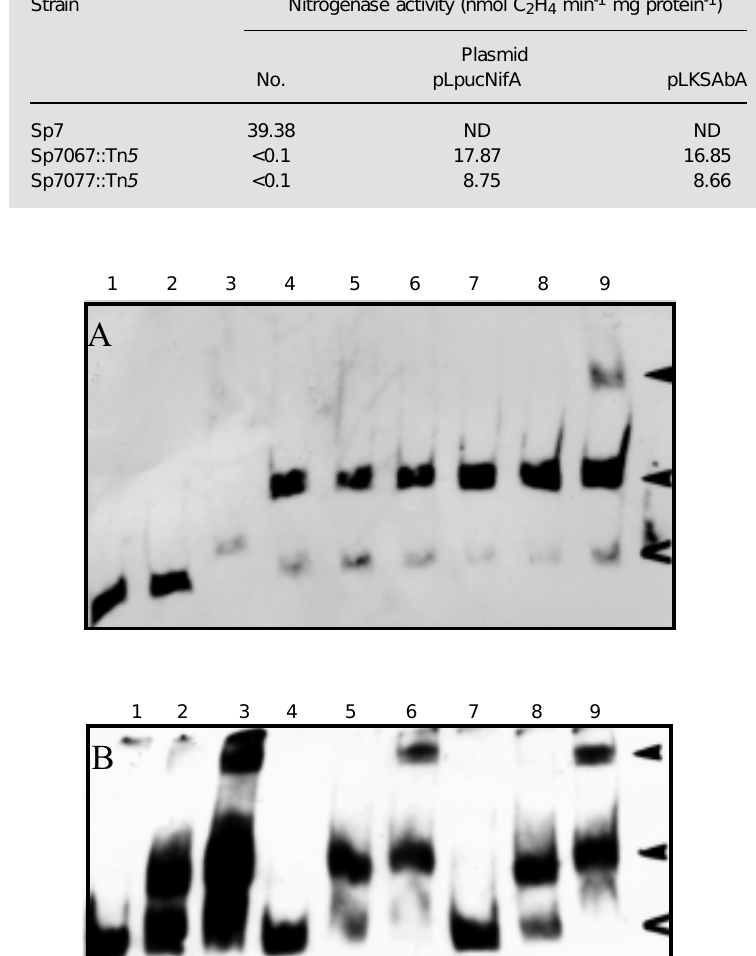
Figure 7 - Binding of NifA protein to the nifH UAS promoter region by gel-mobility shift assay. A , The 200-bp DIG labeled DNA fragment was incubated with crude cell superna- tant from E. coli strains (20 µg total extract/reaction) containing the K. pneumoniae NifA protein synthesized by plasmids pCK3 (lane 4), pAKpA (lane 5) and pGEXKpA (lane 6) or A. brasilense NifA protein synthesized by plasmids p10 (lane 7), pAAbA (lane 8) and pGEXAbA (lane 9), alone or fused with GST protein. Lane 1, control of DNA fragment; lane 2, the control of the DNA fragment was incubated with MC1061 total extract, and lane 3, a 230-bp DNA fragment with no UAS motif, used as a probe, was incubated with MC1061/pCK3 total extract (negative controls). B , Lanes 1, 4 and 7 correspond to the added wild-type UAS region, UAS1 mutant and UAS2 mutant fragments, respectively. Lanes 2 and 3, wild-type fragment incubated with crude cell supernatant from E. coli strains (20 µg total extract/reaction): MC1061/pAAbA (lane 2) and MC1061/pGEXAbA (lane 3). Lanes 5 and 6, UAS1 mutant fragment incubated with total extracts from MC1061/pAAbA (lane 5) and from MC1061/pGEXAbA (lane 6). Lanes 8 and 9, UAS2 mutant fragment incubated with total extracts from MC1061/pAAbA (lane 8) and MC1061/pGEXAbA (lane 9). The full arrowheads represent the retarded bands and the open arrowhead represents the free-labeled